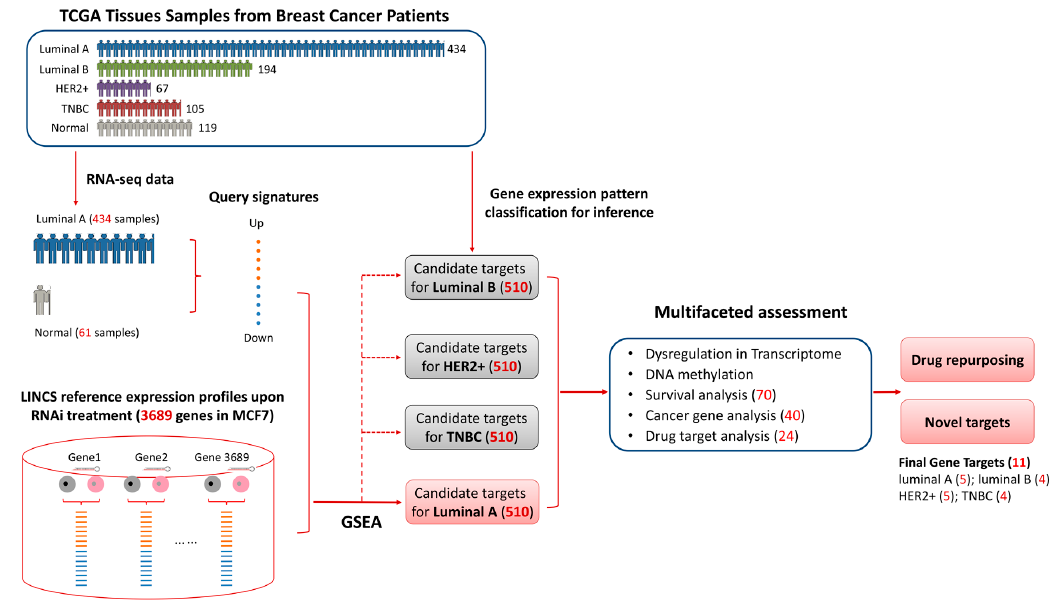
Figure 1. Workflow of candidate therapeutic target identification and multifaceted assessment.